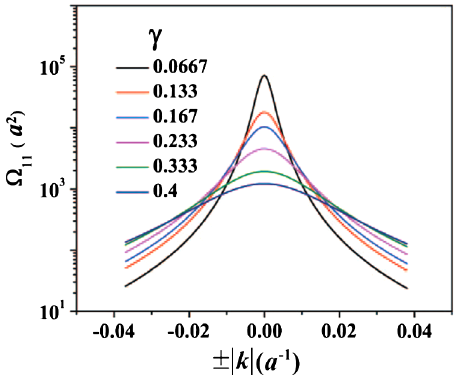
FIG. 3. Berry curvature matrix element Ω 11 calculated as a function of wave vector k for various values of the geometric factor γ [based on Eq. (19)]. The parameter m= ℏ v can be obtained from the tight-binding calculations, where the periodicity L is fixed at 13 nm. Here a denotes the carbon-carbon atomic separation ( ¼ 1 . 42